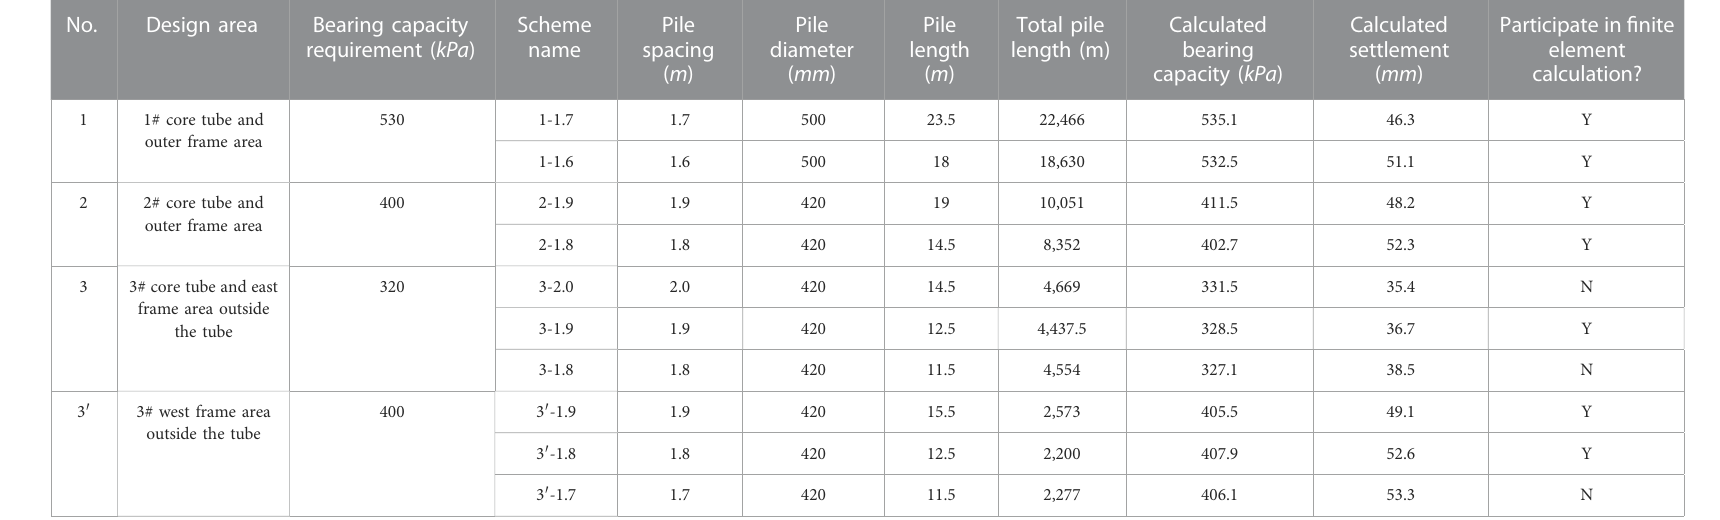
TABLE 3 Bearing capacity and settlement for various combinations of CFG pile lengths and spacing calculated by the standard method.